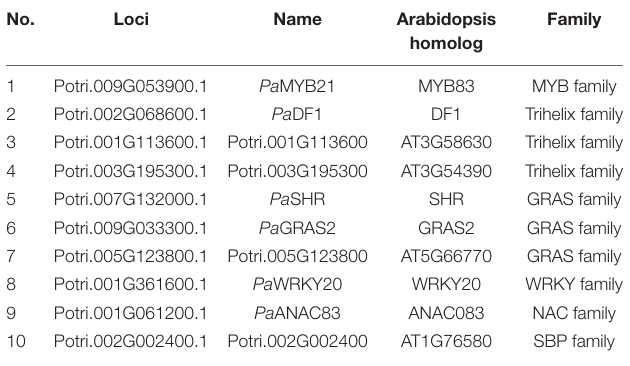
TABLE 2 | Transcription factors that interact with Pa MYB4/LTF1 identified in the Populus wood-associated library using Y2H.